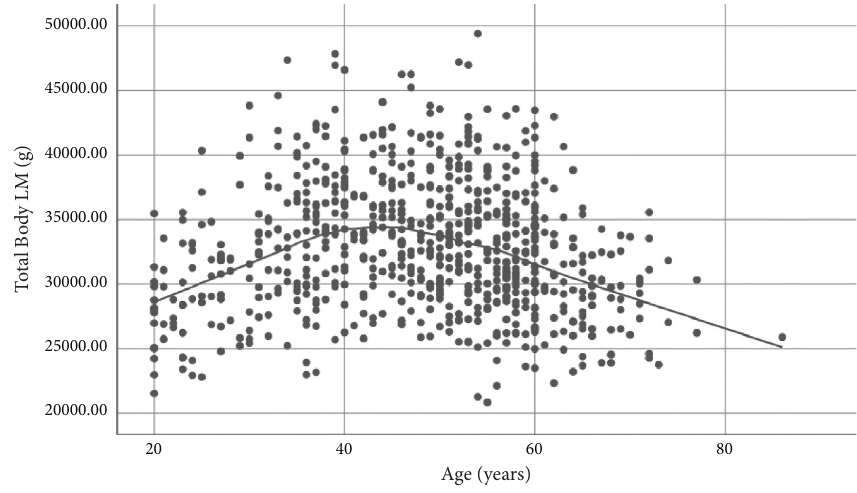
Figure 4: Age-related trend of